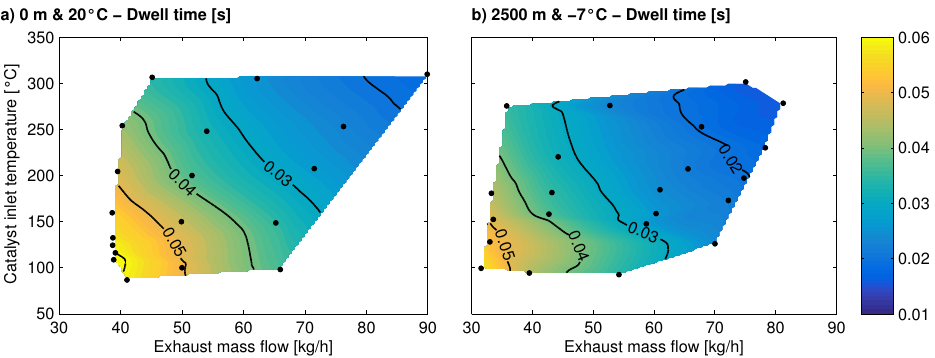
Figure 7. Dwell time as a function of the exhaust mass flow and catalyst inlet temperature: ( a ) 0 m and 20 ◦ C; ( b ) 2500 m and − 7 ◦